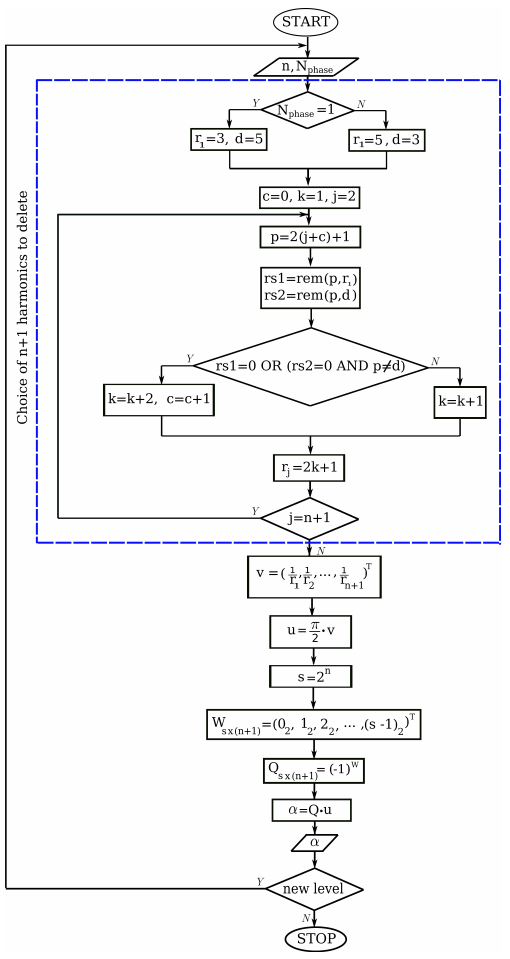
Figure 4. Flow chart of the proposed